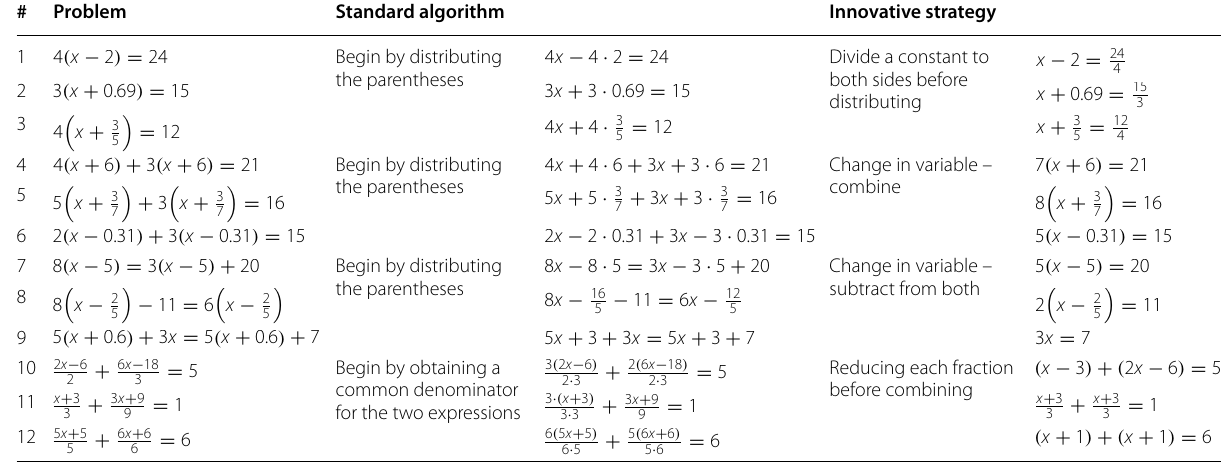
Table 1 Assessment problems, with standard algorithms and situationally appropriate methods #